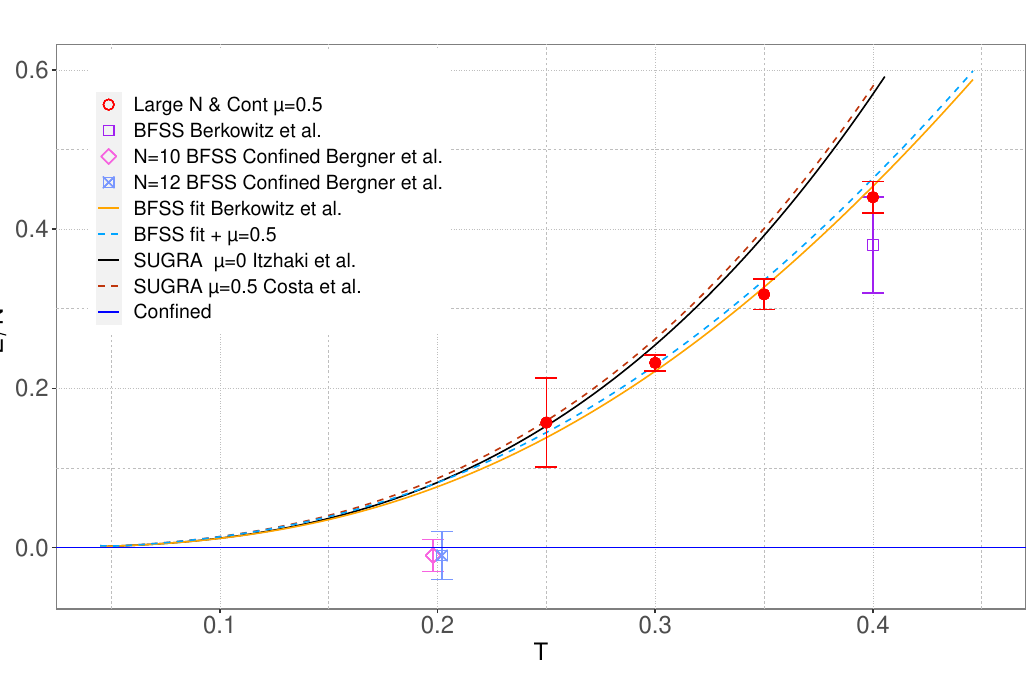
Figure 16 . Zoom-in view of the low-temperature region including the data point in the confined phase from ref. [5]. The effect of the finite value of µ ( µ = 0 . 5 ) is very small and practically negligible. The energy in the confined phase ( E → 0 as N → ∞ ) is clearly different from that in the deconfined N 2 phase ( E ' 7 . 41 T 14 / 5 N 2